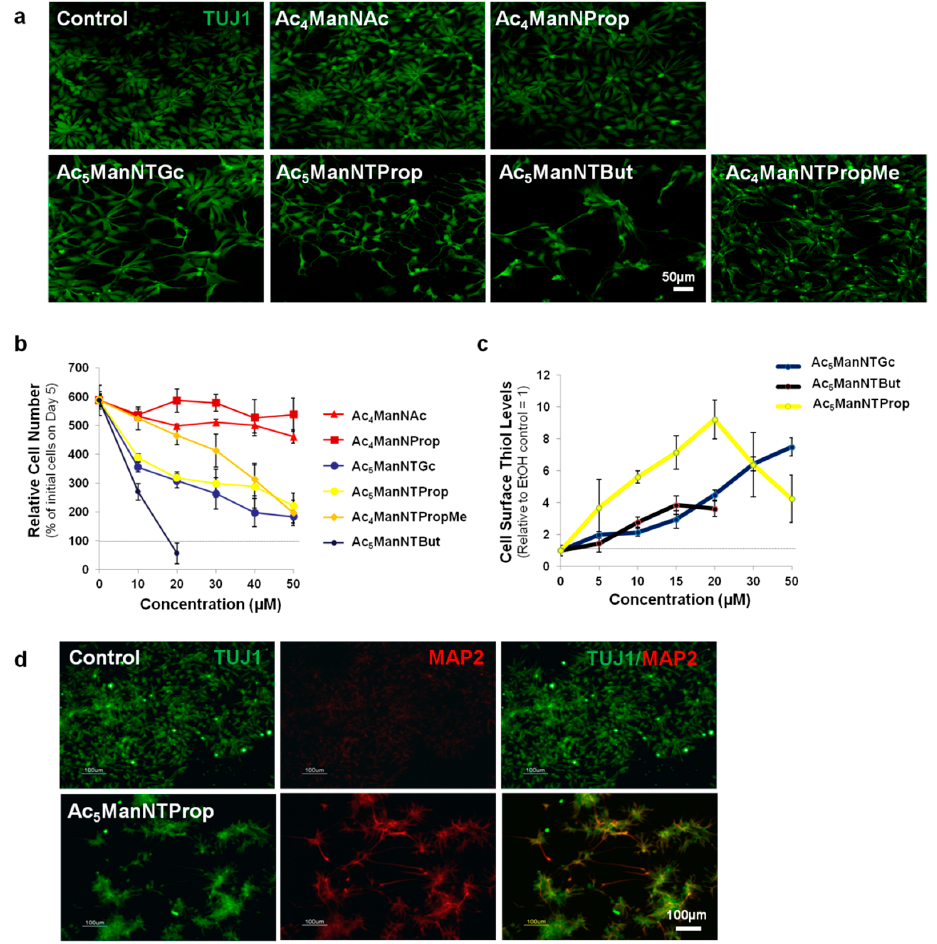
Figure 3. Biological responses of human neural stem cells (hNSCs) treated with thiol-modified ManNAc analogs. ( a ) Fluorescence microscopy images (stained by TUJ1, an antibody for class III β -tubulin protein) of control and Ac 4 ManNAc- and Ac 4 ManNProp-treated hNSCs showed that these unthiolated ManNAc analogs did not noticeably alter cell morphology (top row). Comparison of these results with the three thiol-modified analogs showed clear morphological changes and reduced cell numbers upon Ac 5 ManNTProp and Ac 5 ManNTBut treatment, with weaker responses observed for Ac 5 ManNTGc (bottom row). In addition, the thio-ether analog Ac 4 ManNTPropMe is shown in the bottom row; despite containing a sulfur atom, this analog cannot be metabolically converted to a thiol and elicits biological responses similar to those of the non-thiolated analogs shown in the top row. ( b ) Dose-response experiments showed that only Ac 5 ManNTBut was cytotoxic at concentrations up to 50 μ M after Day 5 (i.e., there were fewer cells on Day 5 than were plated on Day 0); the other analogs slowed the growth of the cells but did not induce cell death, consistent with the cell densities shown in ( a ). ( c ) Cell surface thiols were quantified by flow cytometry-based on our published protocols [21] with ethanol control samples arbitrarily set to a value of 1.0. ( d ) Evaluation of neuronal differentiation by TUJ1 (green) and MAP2 (red, a marker of mature neurons) in ethanol control (top row) and Ac 5 ManNTProp-treated (bottom row) hNSCs. In these experiments, hNSCs were plated on laminin-coated surfaces on Day 0, analogs were added at 20 μ M concentration on Day 1 and replenished every second day. The cells were stained and imaged on Day 5 and Day 9 for ( a , d ), respectively. Experiments were performed in triplicate and repeated three times. The cells in ( a ) are shown at higher magnification to depict morphology more clearly. The scale bar was 50 and 100 μ m for ( a , d ), respectively.